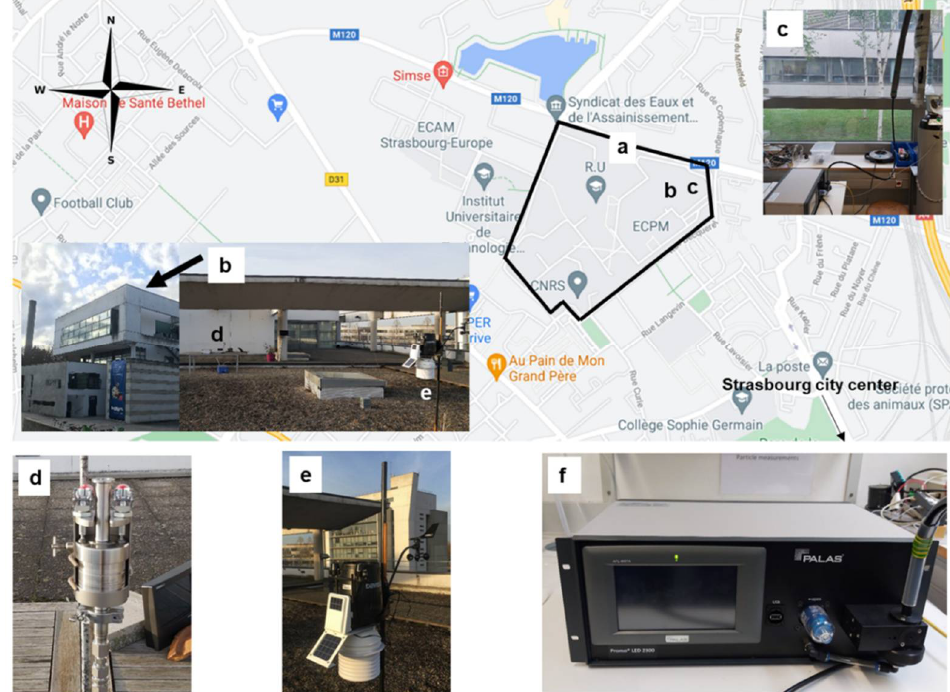
Figure 1. Location and pictures of the experiment sampling sites and different equipment: ( a ) Cronenbourg campus; ( b ) ECPM rooftop (three-stage cascade impactor sampling site, weather station location); ( c ) ICPEES (particle analyser sampling site); ( d ) three-stage cascade impactor (DEKATI); ( e ) weather station; ( f ) particle analyser Palas Promo LED 2300.